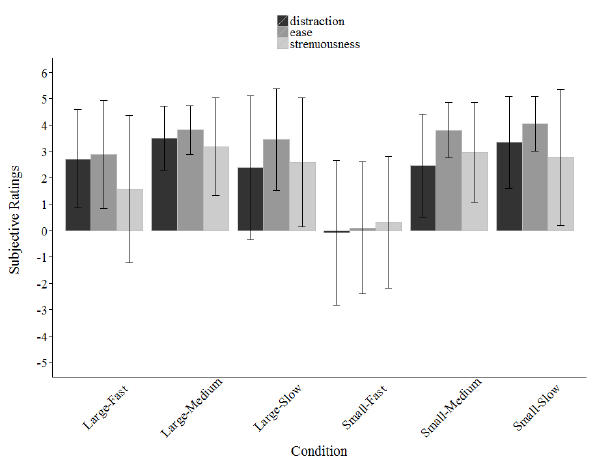
Figure 3. Mean subjective rating results of user friendliness (-5 to +5 rating scale, error bars indicate standard